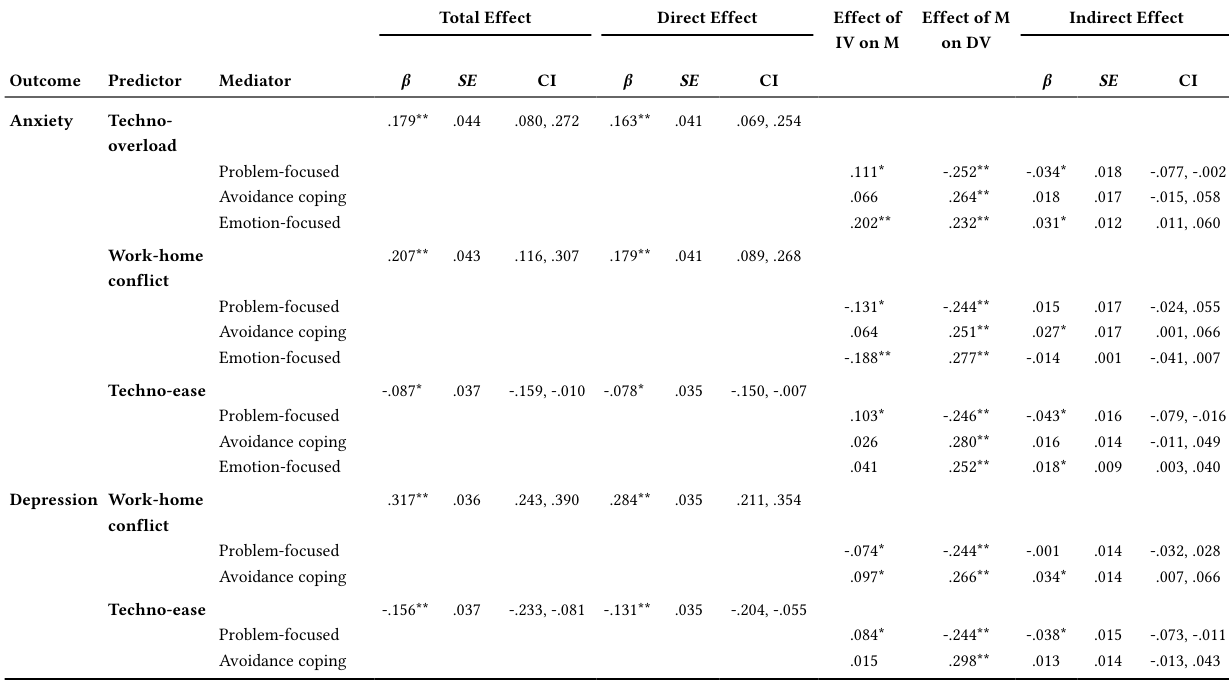
Outcomes of Multiple Mediation Analyses (Bootstrapped 5000